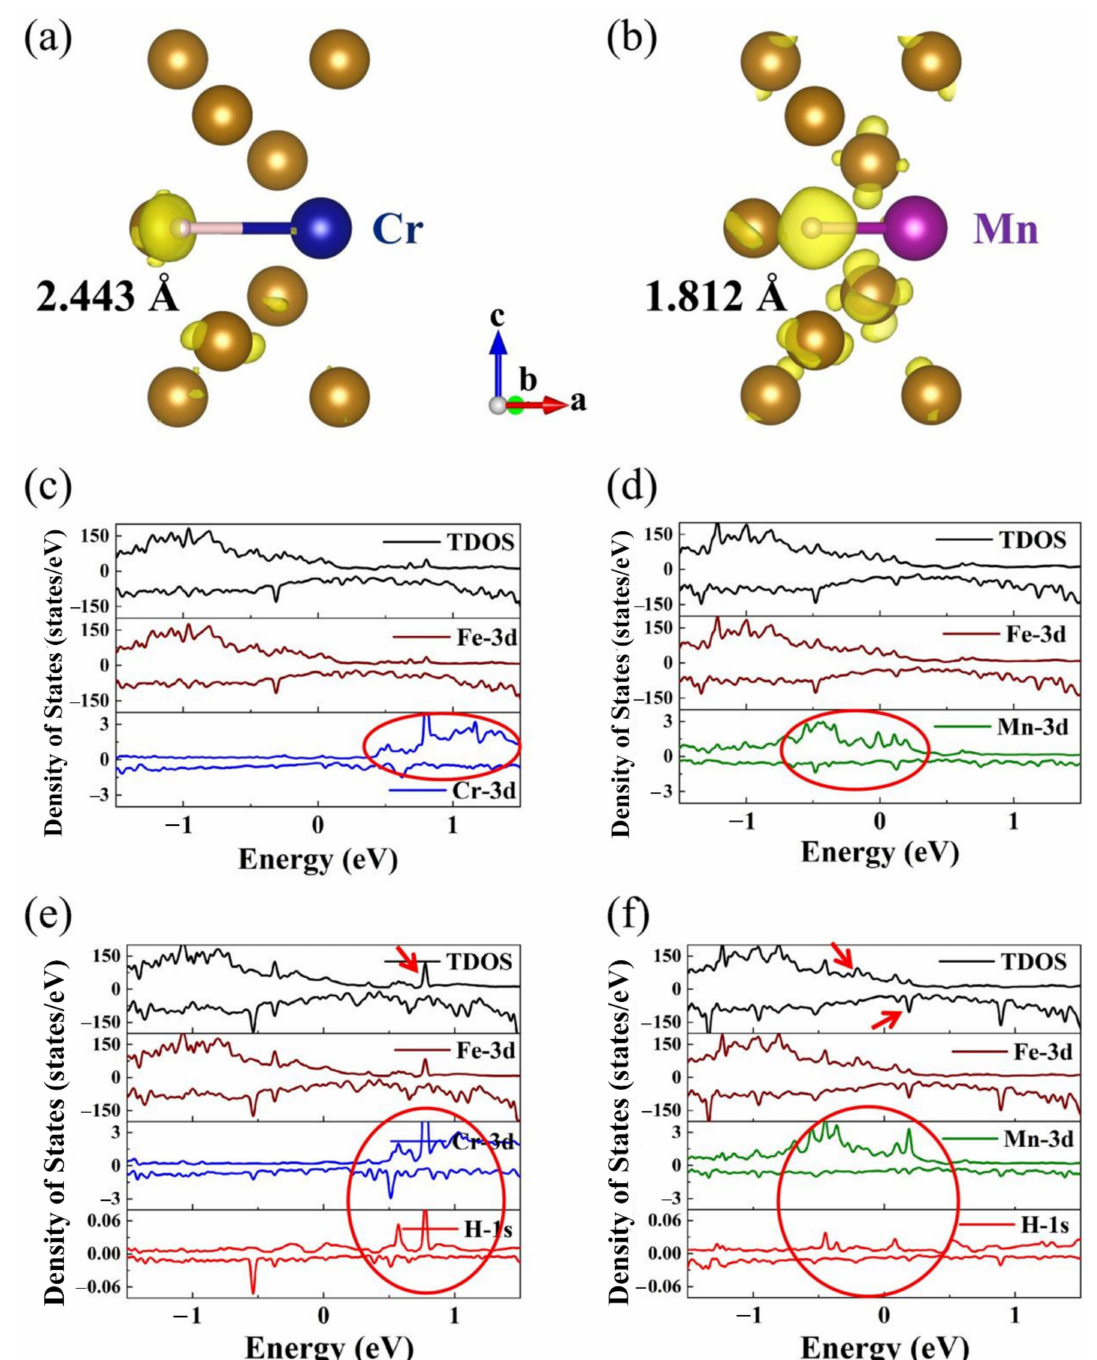
Figure 6. ( a ) Differential charge density of H in Cr doped structure; ( b ) Differential charge density of H in Mn doped structure; The charge density iso-surface is set to be 0.005 e/Å 3 ; ( c ) The density of states with spin-up and spin-down for Cr doping in bcc-Fe Σ 5 GB without H atom; ( d ) The density of states with spin-up and spin-down for Mn doping in bcc-Fe Σ 5 GB without H atom; ( e ) The density of states for Cr doped structure with H atom; ( f ) The density of states for Mn doped structure with H